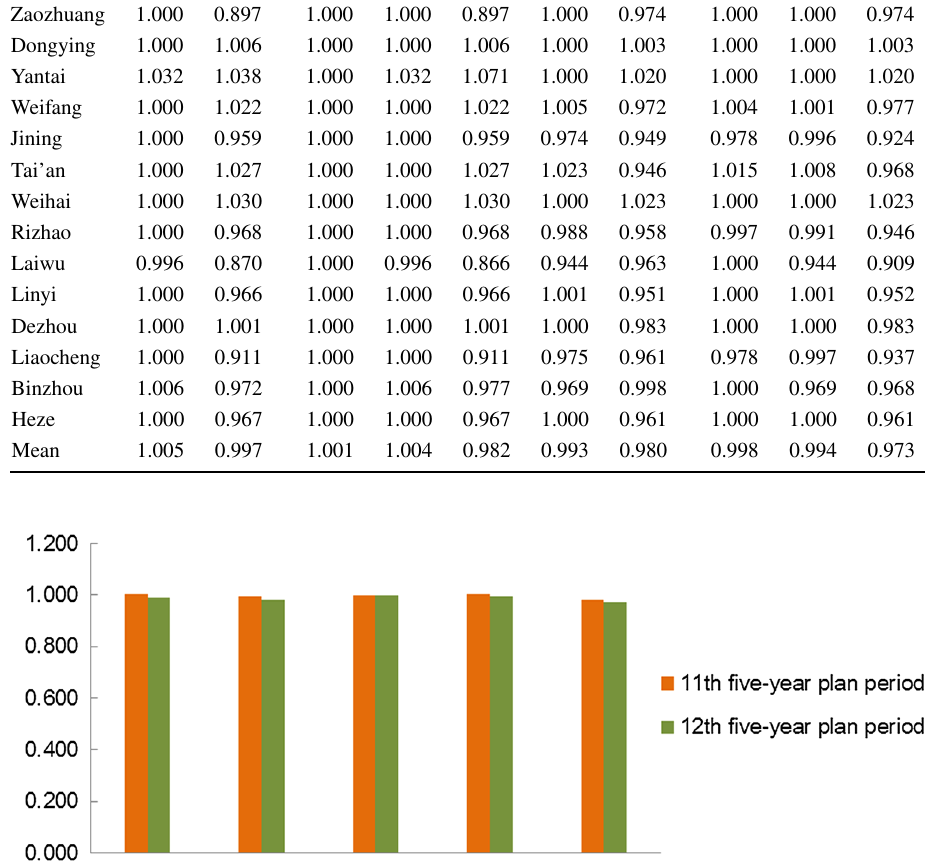
Table 4 A summary of TFPs of 17 cities in Shandong Province during 11th and 12th Five-year Plan periods